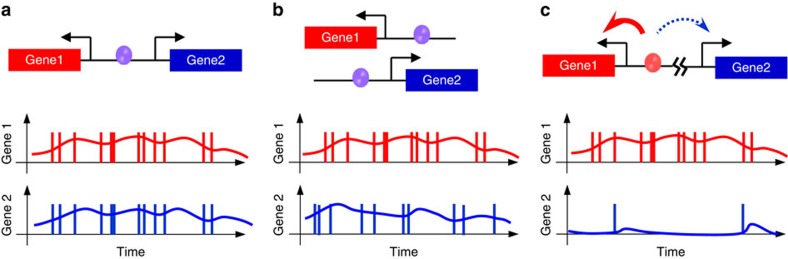
Models of the stochastic DGP transcription.(a) Two genes in a DGP may have enhanced covariance in their expression. Stochastic binding of transcription factors contributes to gene expression noise. In the case of a co-regulated DGP, where the two genes are under the control of the same transcription factor binding events, the transcription initiation of the two genes may occur simultaneously (vertical bars in the lower panel). Although the synchrony level of gene expression is likely to be reduced by subsequent stochastic events such as transcription elongation and termination, we still expect more synchronized fluctuations in the protein level of the two genes (curves in the lower panel). (b) Two separate genes driven by the same divergent promoter as in a may experience independent factor binding and asynchronized transcription firing. (c) In a differentially regulated DGP where the two genes respond to different transcription factors, the regulatory signal may ‘leak' stochastically to the wrong side. For every activation event of gene 1, if the leakage occurs sporadically in a fraction of cells, it may result in enhanced expression noise of gene 2. The notations in the diagrams are: black arrows, TSS; purple and red ovals, transcription factors; red and blue arrow in c, major and minor activation. The same notation applies to the following figures if not specified.